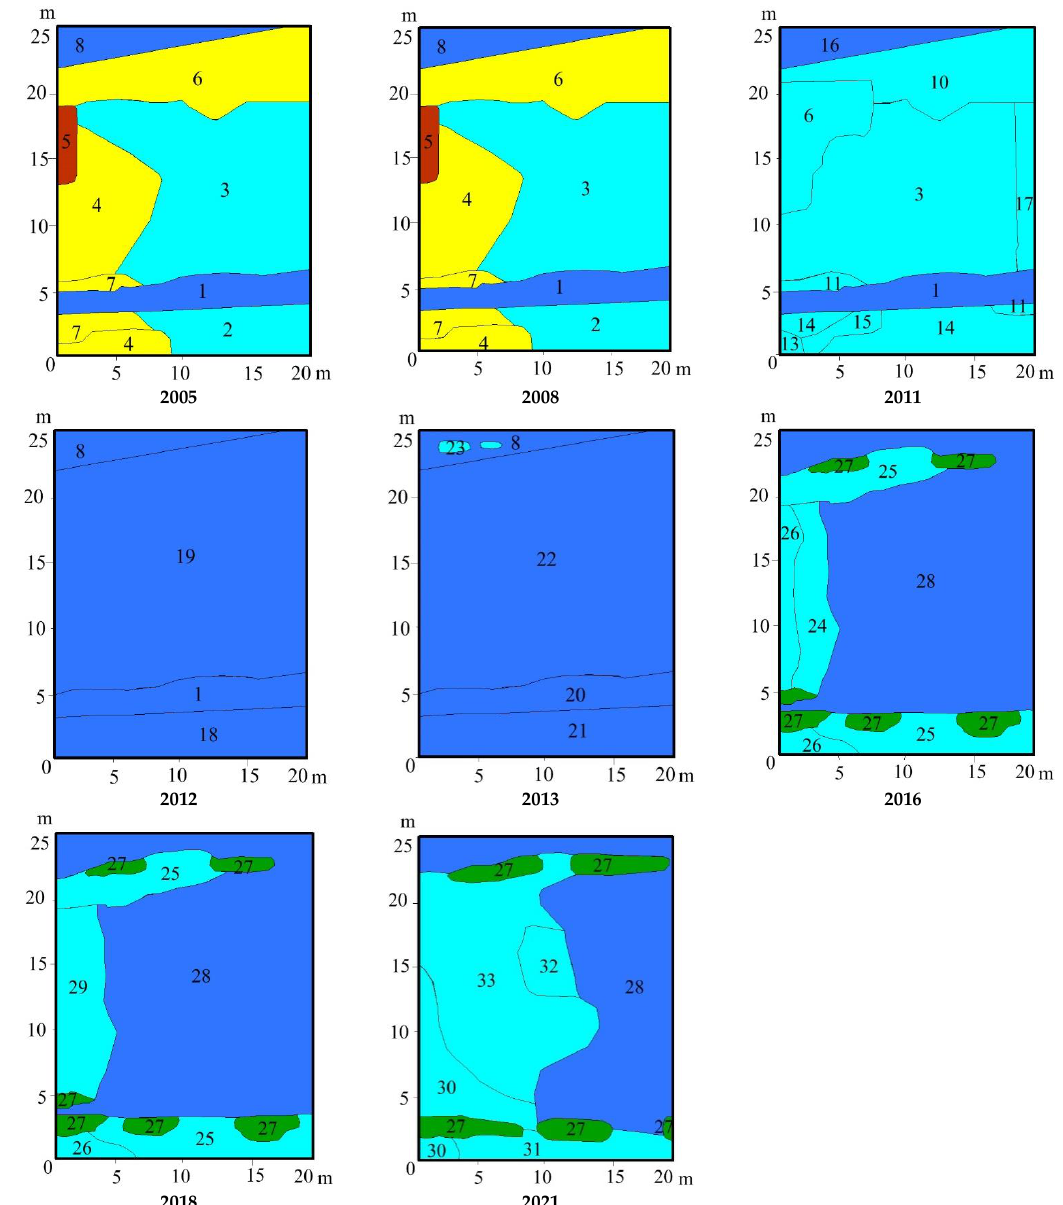
Figure 16. Changes in vegetation on permanent plot No. 1: 1 Calla palustris + Typha latifolia ; 2 B etula pubescens – Eriophorum vaginatum ; 3 E. vaginatum ; 4 B. pubescens – Polytrichum juniperinum ; 5 bare